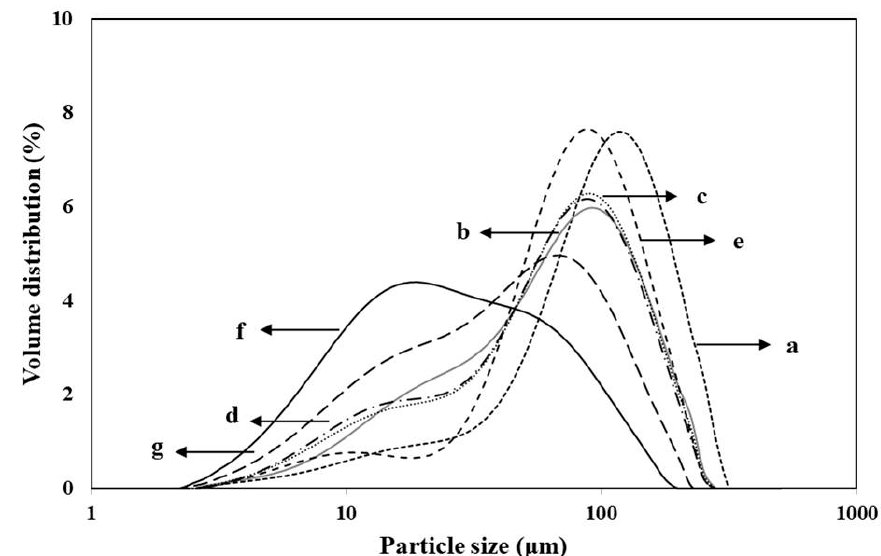
Figure 1. Particle size distribution of flours from six rice and one wheat varieties. ( a ) Ilpum, ( b ) Keumkang, ( c ) Seolgaeng, ( d ) Hangaru, ( e ) Shingil, ( f ) Garumi 2-P, and ( g ) Garumi 2-N. D 50 = 50% of cumulative particle size distribution.